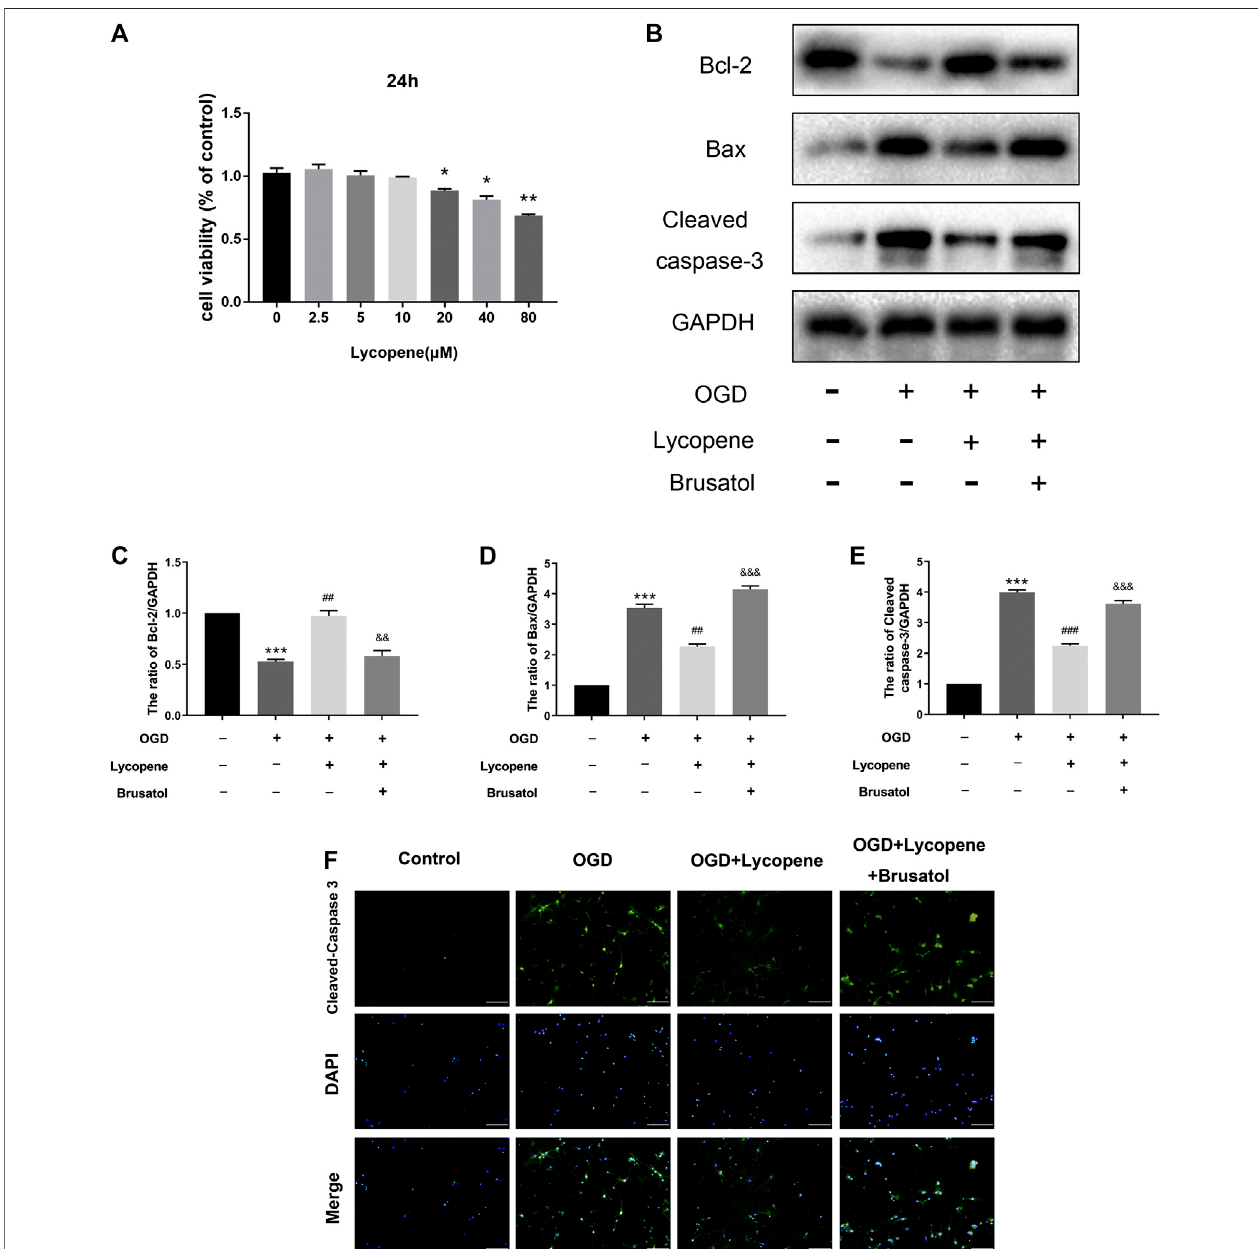
FIGURE 6 | Treatment with Lycopene (Lyc) alleviated oxygen-glucose deprivation (OGD)-induced apoptosis in primary cortical neurons. (A) Using CCK8 analysis, thecytotoxiceffectofLyc(0,2.5,5,10,20,40and80 μ M)onprimarycorticalneurons.* p < 0.05,** p < 0.01vs.thecontrolgroup.Alldataarepresentedasmean ± SEM, n (cid:2) 3. (B) The protein levels ofBcl-2, Bax and Cleaved caspase-3 were assessed bythe Western blot. (C,E) Quantitative analysisofBcl-2, Baxand Cleaved caspase-3. *** p < 0.001vs.thecontrolgroup; ## p < 0.01and ### p < 0.001vs.theOGDgroup; && p < 0.01and &&& p < 0.001vs.theOGD+Lycgroup.Alldataarepresentedas mean ± SEM, n (cid:2) 3. (F) The representative fl uorescence image of Cleaved caspase-3 with DAPI (nuclei). Scale bar (cid:2) 100 μ m.